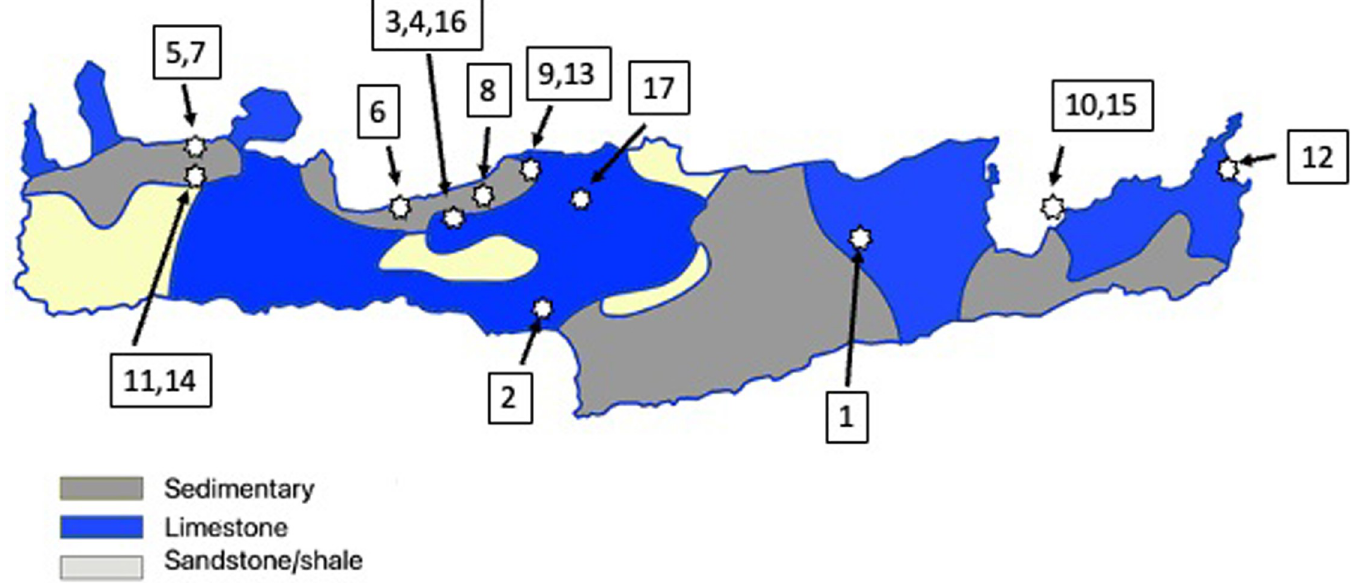
Fig 1. Map of the approximate locations of the study sites in Crete plotted on a simplified geological map (modified after [20]). (1) Agios Charalambos, (2) Apodoulou, (3) Armenoi, (4) Chamalevri, (5) Chania, (6) Gerani, (7) Kastelli, (8) Maroulas, (9) Melidoni, (10) Mochlos, (11) Nerokourou, (12) Palaikastro, (13) Perama Margaritas, (14) Platyvola, (15) Pseira, (16) Vrysinas, (17)